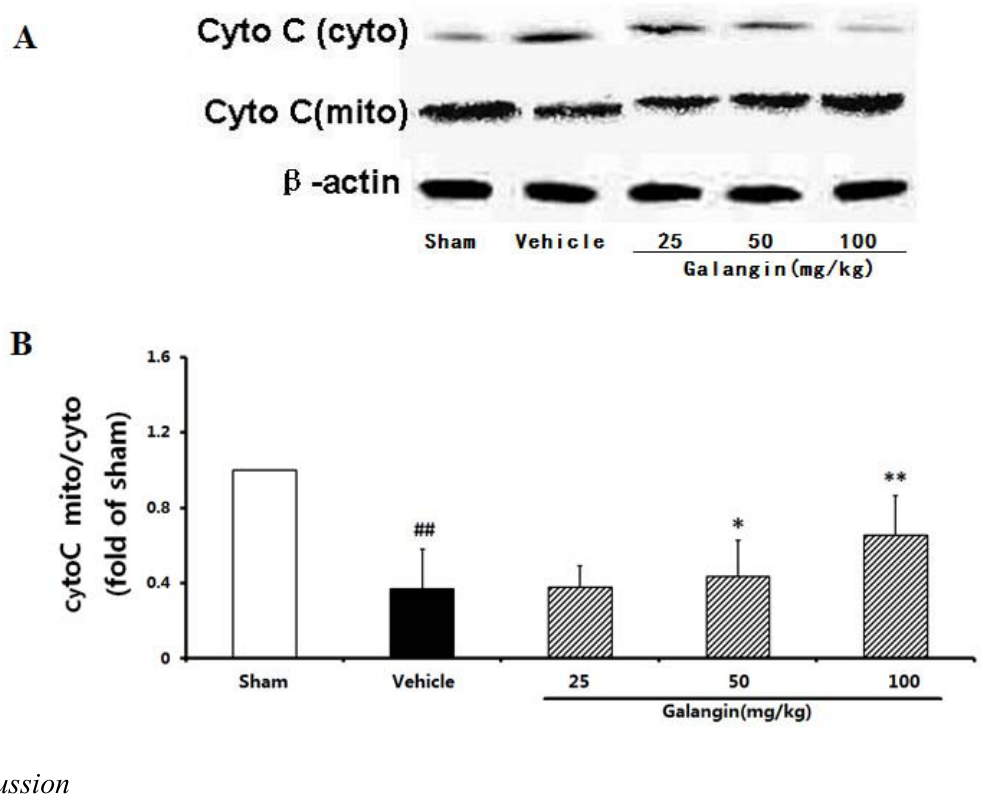
Figure 11. Effects of galangin on cytochrome c release from rat brain mitochondria 24 h after MCAO. Galangin was administered by i.g. 15 min prior to MCAO. ( A ) Cytochrome c protein levels in the cytosolic and mitochondrial fractions; ( B ) The quantified densitometric analysis of cytochrome c. The values were expressed as the mean ± SD for four independent experiments, and the data were analyzed by one-way ANOVA. ## p < 0.01, # p < 0.05 versus the sham group; ** p < 0.01, * p < 0.05 versus the vehicle